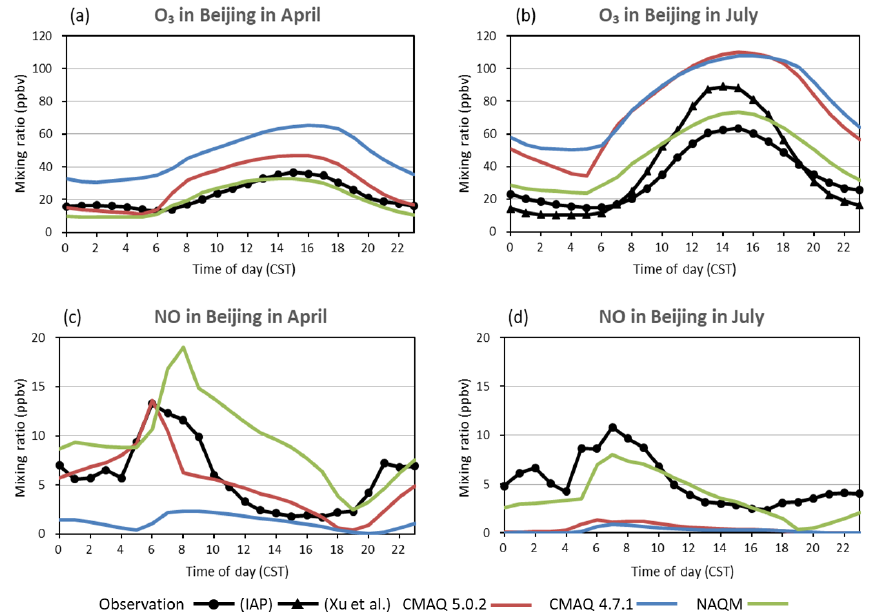
Figure 2. Monthly averaged diurnal variation in Beijing, (a) O 3 in April, (b) O 3 in July, (c) NO in April, and (d) NO in July.